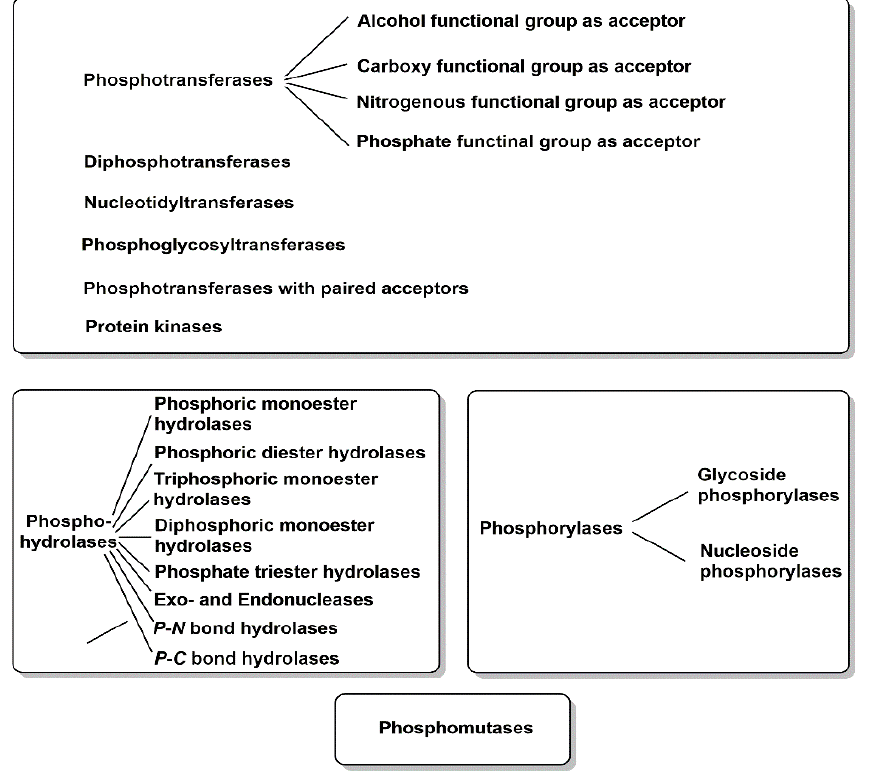
Figure 2. Overview of major functions of phosphoryl-group transferring biocatalysts.